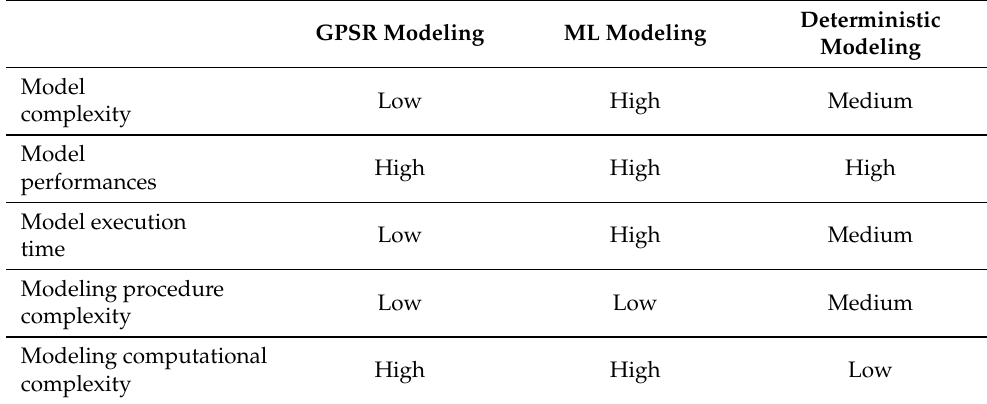
Table 6. The cost comparison of GPRS modeling, ML modeling, and deterministic